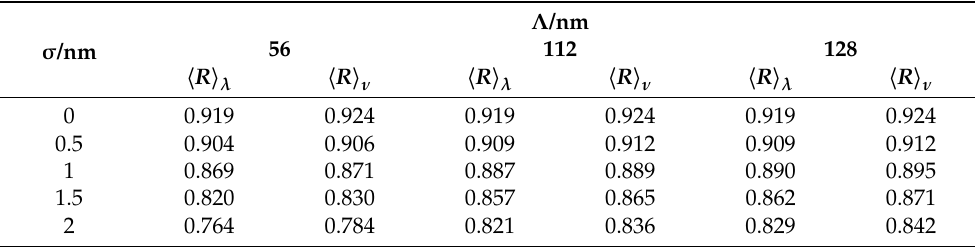
Table 3. Averaged calculated reflectances for assumed pure aluminum surfaces for simulated lateral periods Λ and roughnesses σ .